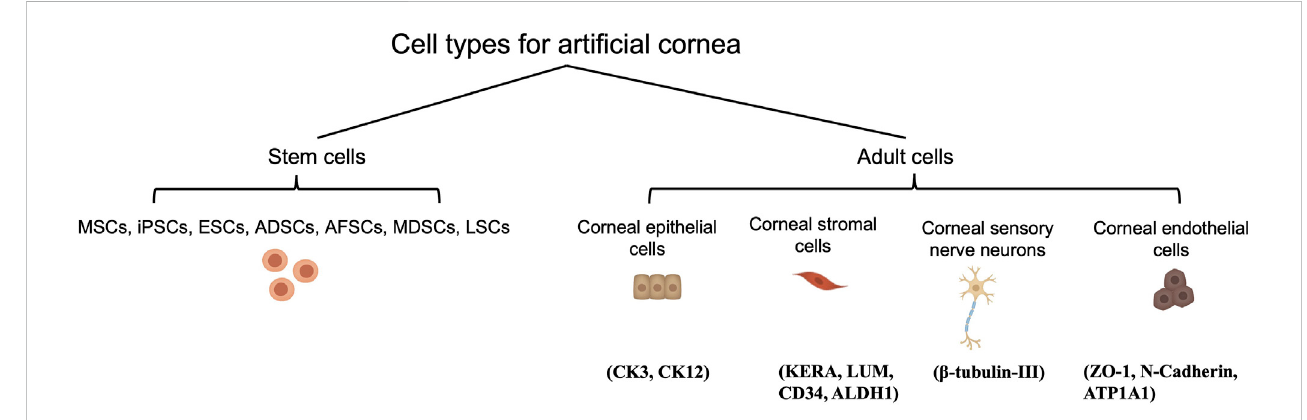
FIGURE 5 Cell types possible for 3D bioprinting of cornea and their corresponding phenotypic